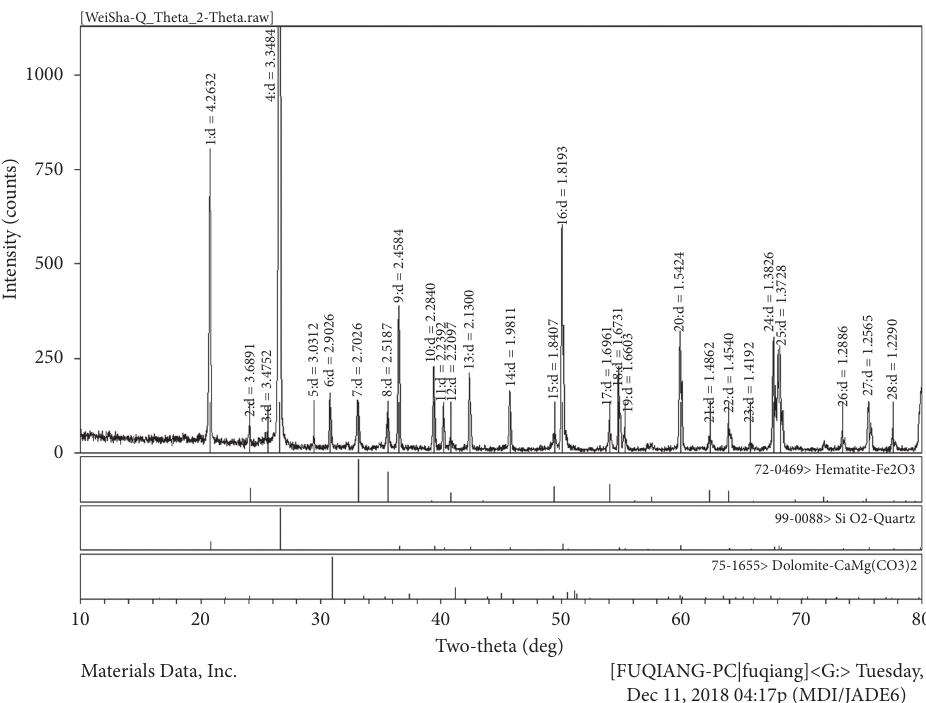
Figure 2: XRD profiles of the